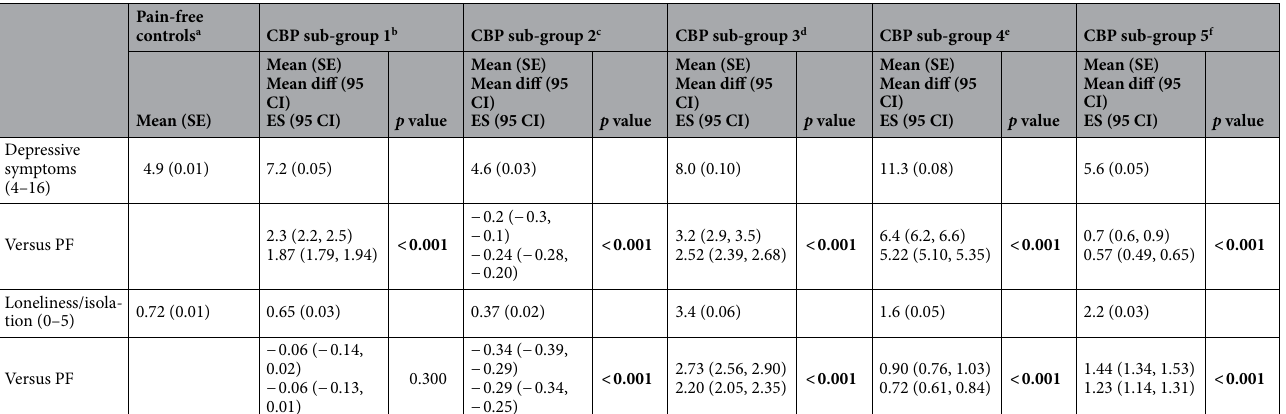
Table 2. Results of the Analysis of Covariance (ANCOVA) for sub-groups derived from psychosocial variables. Data are presented as adjusted mean (standard error). Adjusted mean differences and 95% confidence interval (95 CI) are reported. Effect sizes and 95% confidence intervals were calculated using standard formulae. All data were adjusted for age and sex. p value s were adjusted for multiple comparisons using Tukey HSD method. PF pain-free, 95 CI 95% confidence interval, ES effect size. Significant values are in [bold]. a Pain-free individuals (n = 14,927; 78.2%). b CBP sub-group 1: low social isolation/loneliness and moderate depressive symptoms (n = 776; 4.1%). c CBP sub-group 2: low loneliness/social isolation and depressive symptoms (n = 2296; 12.0%). d CBP sub-group 3: high loneliness/social isolation and moderate depressive symptoms (n = 185; 1.0%). e CBP sub-group 4: moderate loneliness/social isolation and high depressive symptoms (n = 297; 1.6%). f CBP sub-group 5: moderate loneliness/social isolation and low depressive symptoms (n = 603; 3.2%).